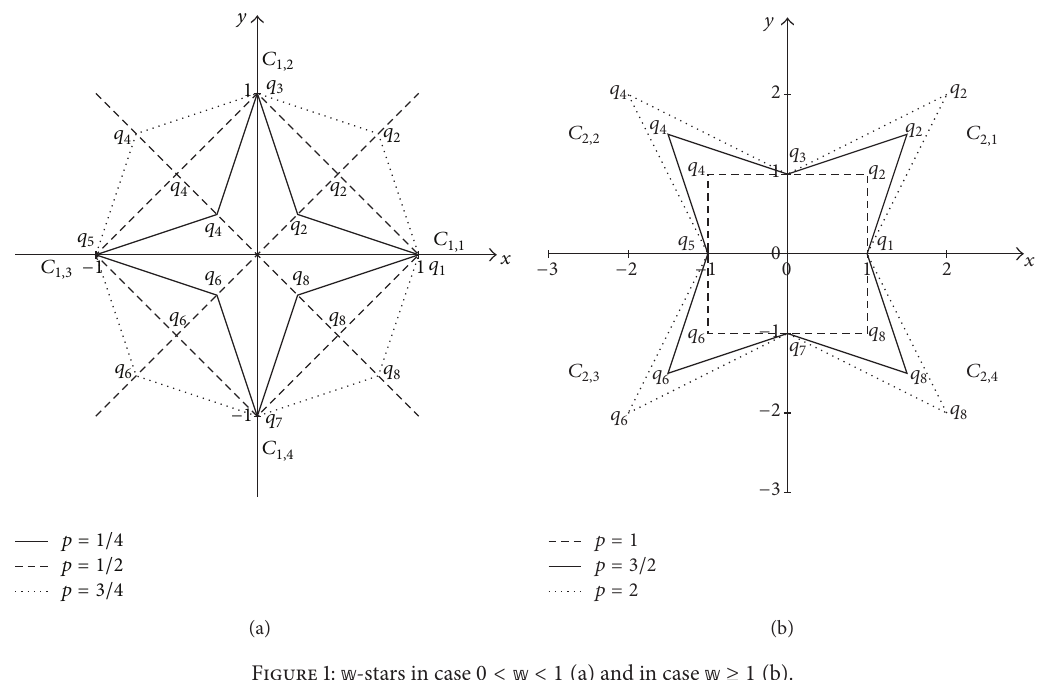
Figure 1: w -stars in case 0 < w < 1 (a) and in case w ≥ 1